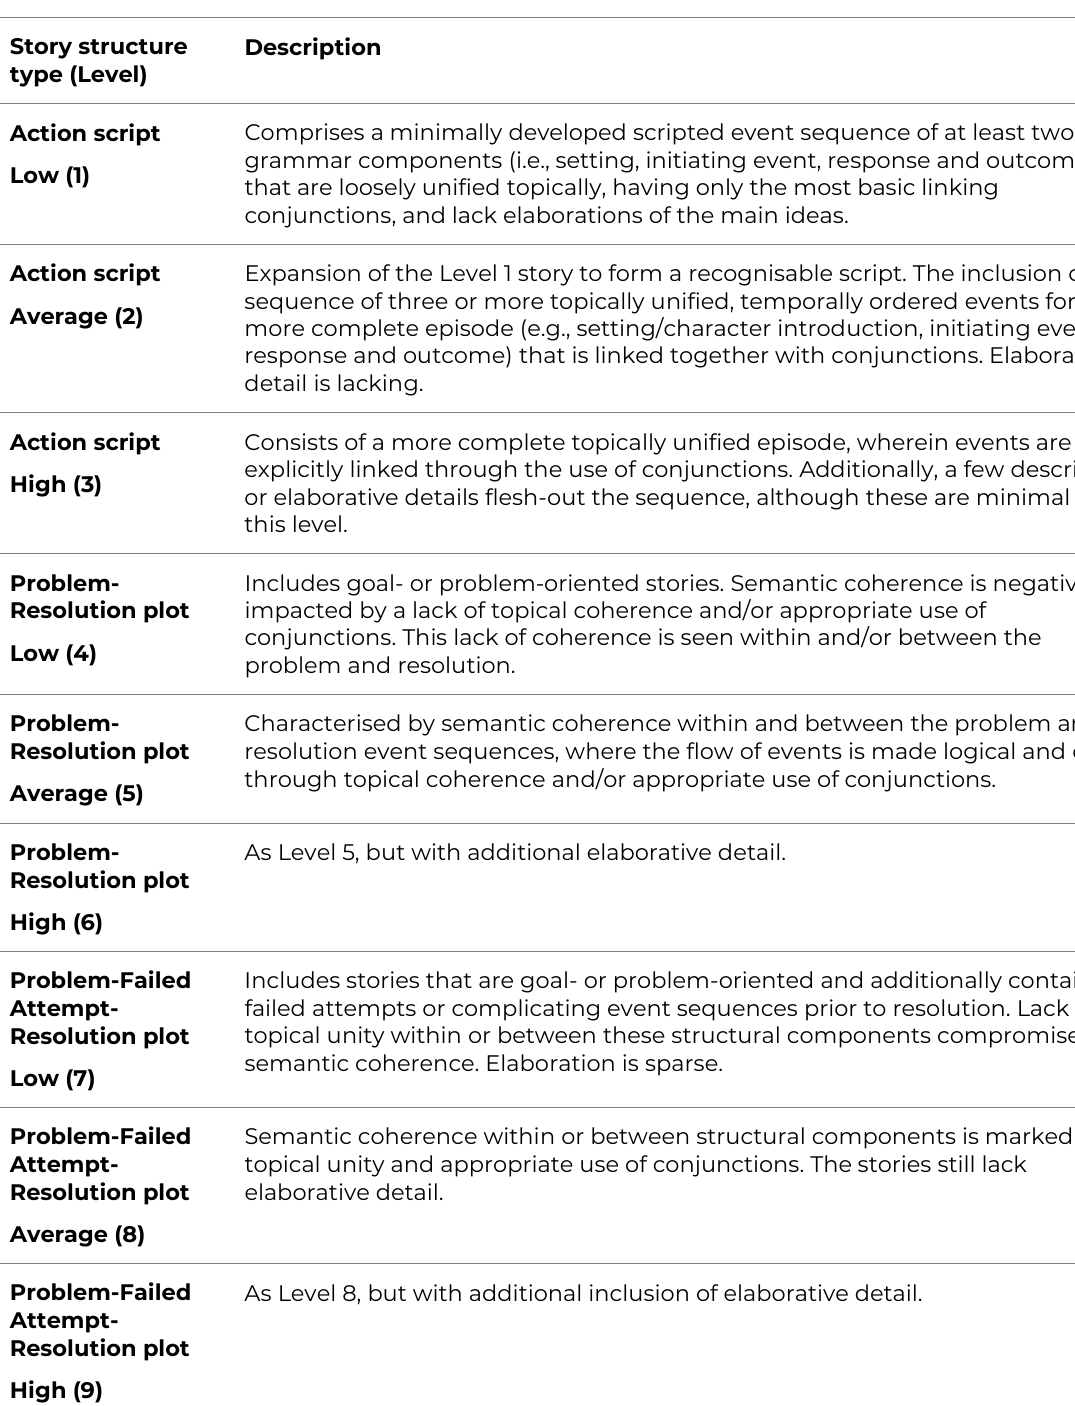
Table 2: Developmental story structure scoring